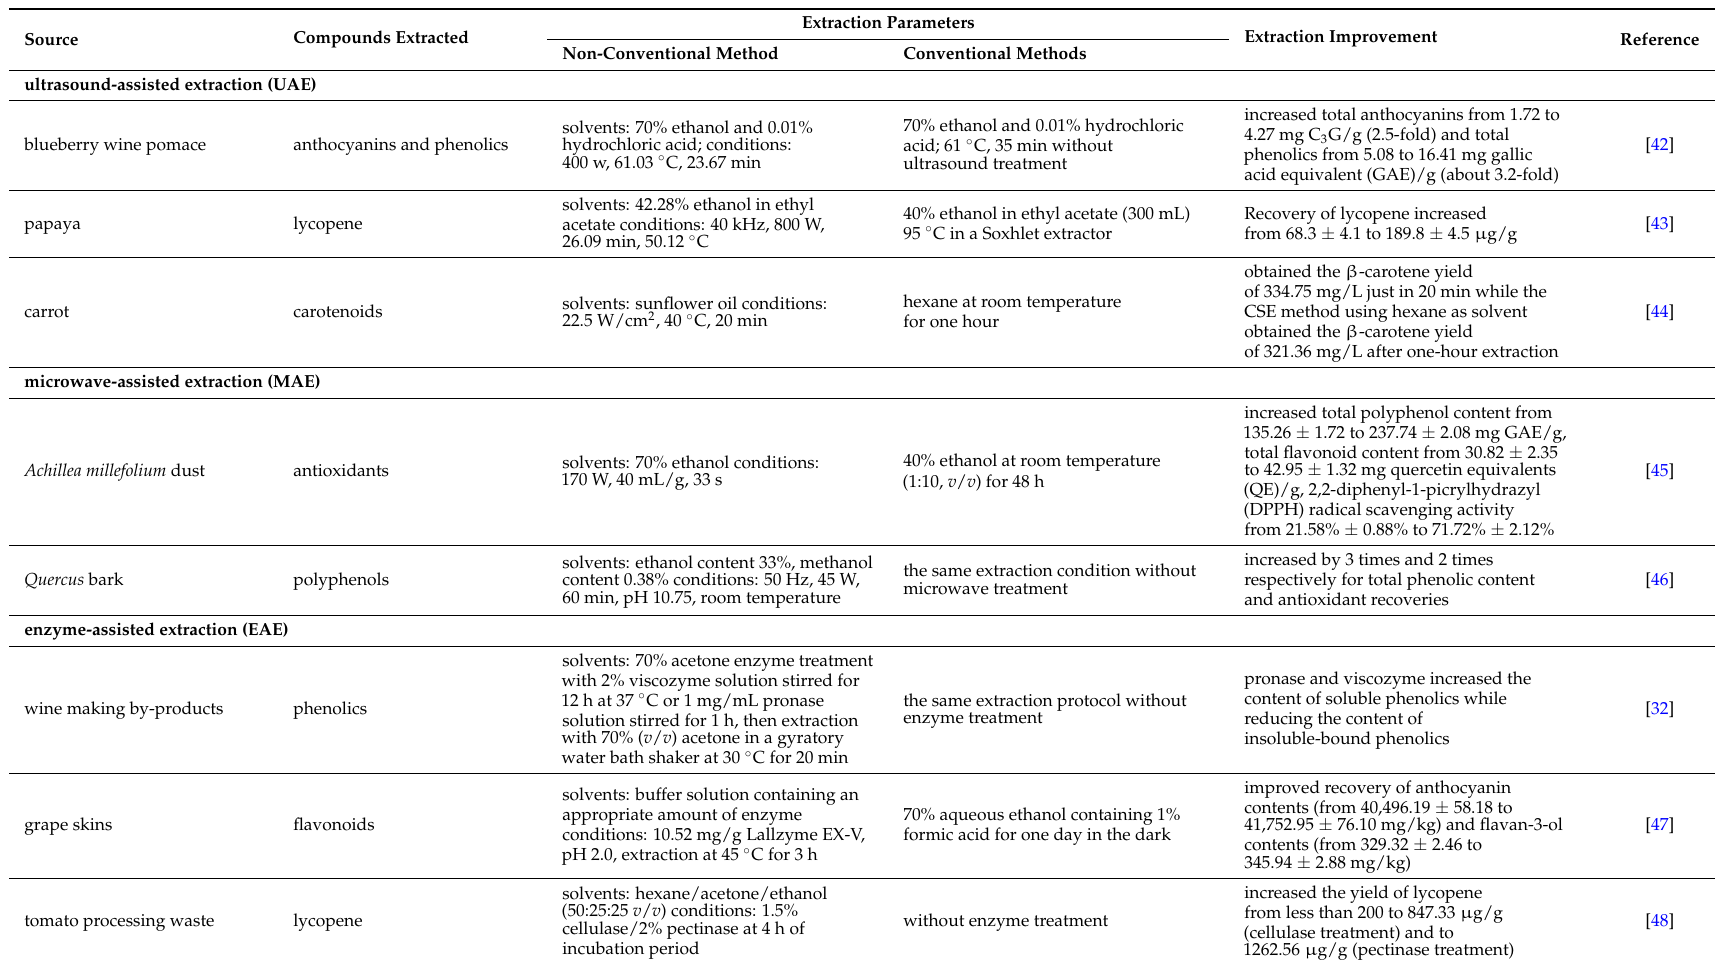
Table 1. The application of non-conventional techniques in the extraction of antioxidants from some foods and medicinal